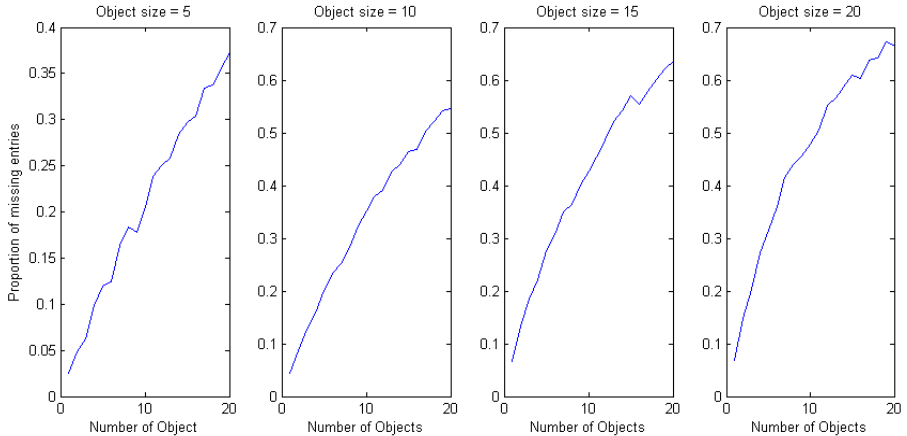
Figure 3. Graphs of the effects of object size to the proportion of missing entries for object size equal to 5, 10, 15, and 20 cm.